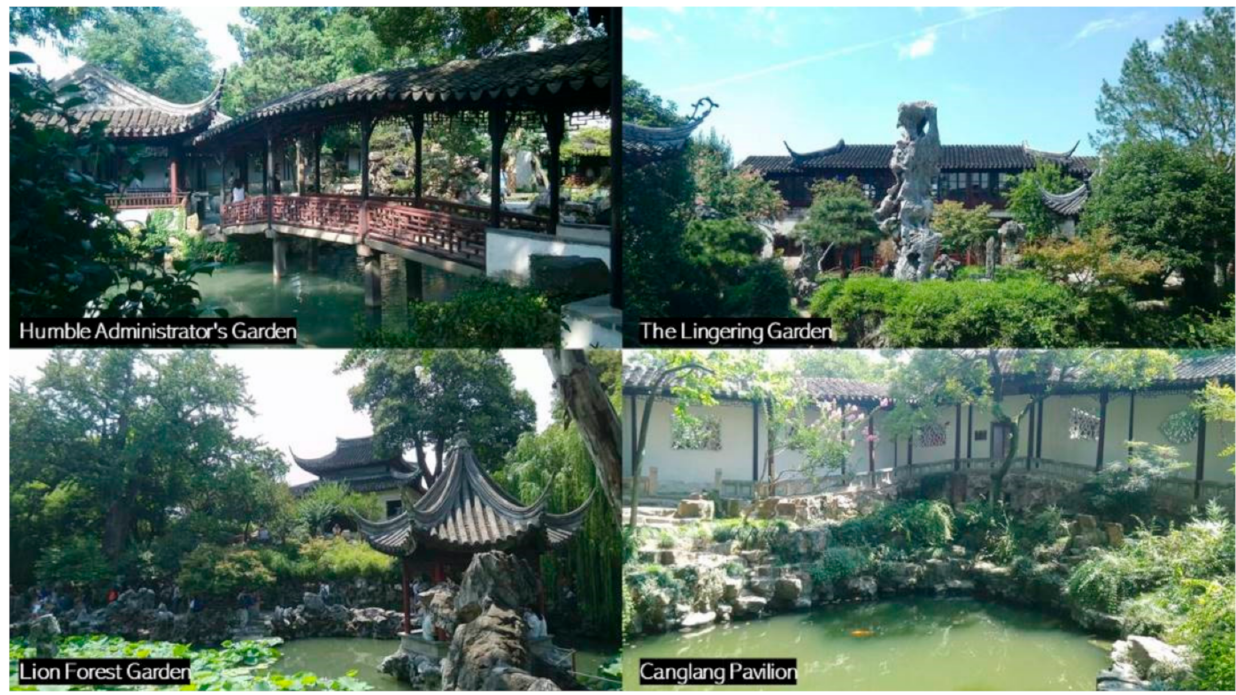
Figure 2. Typical representative images of Jiangnan gardens. (Image source: photographed and annotated by the